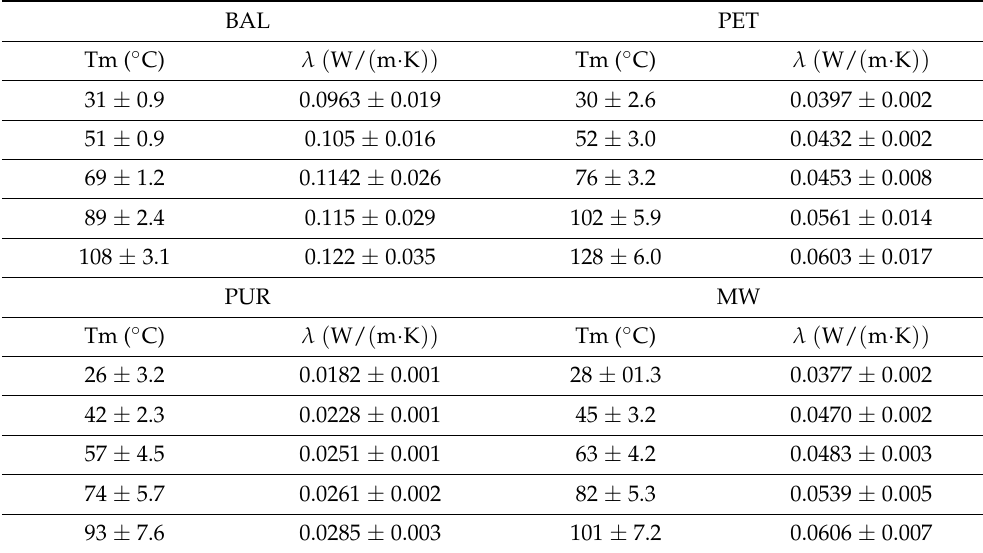
Table 4. Thermal conductibility ( W/ ( m · K )) evaluated for layer 3 (the mean and the standard deviation of three test specimens).